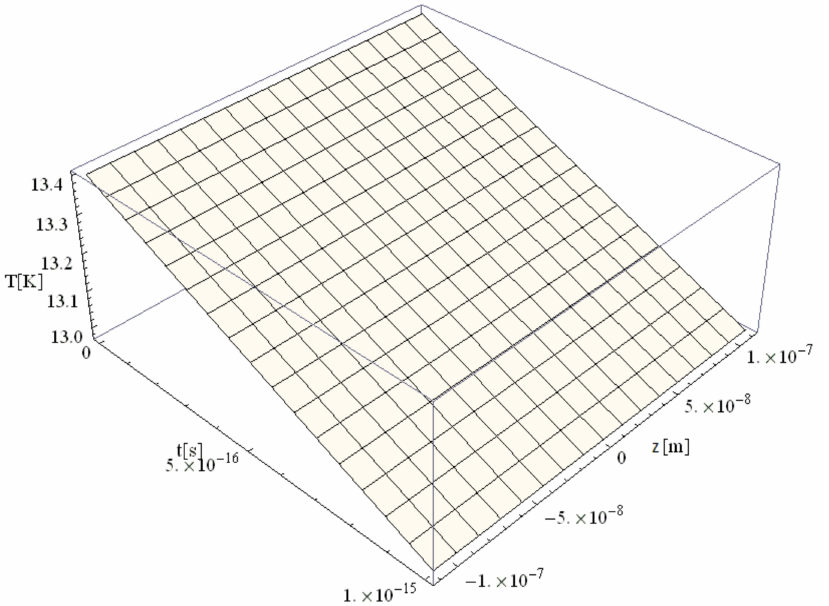
Figure 4. Electron temperature versus time and z during 1 fs simulation after irradiation with a 100 as laser pulse applied to an Au microparticle with a 110 nm radius.